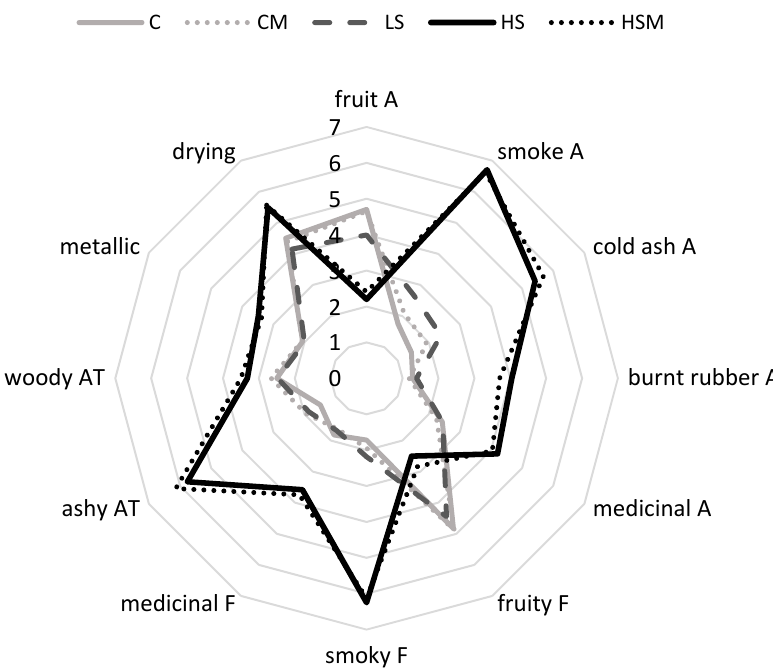
Figure 2. Sensory profiles of control and smoke-affected wines; A = aroma; F = flavor; AT = aftertaste. C = control (no smoke exposure); CM = control with misting; LS = low density smoke exposure; HS = high density smoke exposure; HSM = high density smoke exposure with misting. Values are mean intensity ratings of one wine per treatment, presented to 50 judges; ratings for each attribute were statistically significant ( P = 0.05, one-way ANOVA).